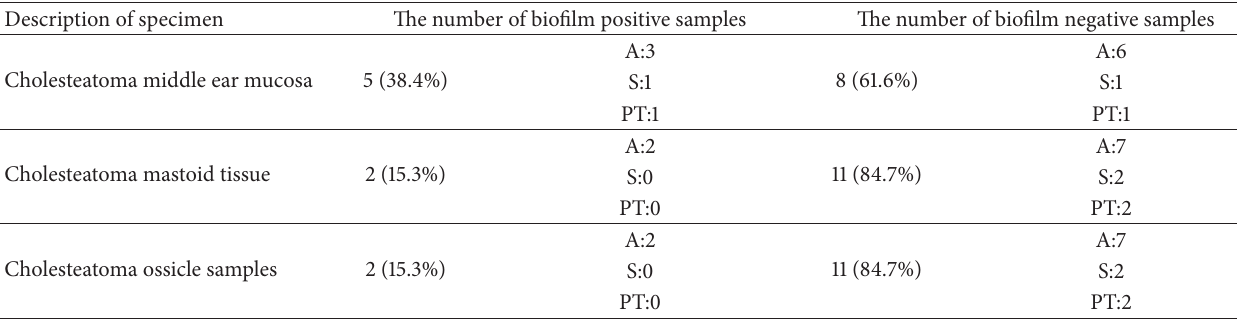
Table 3: The presence of biofilm in acquired cholesteatoma